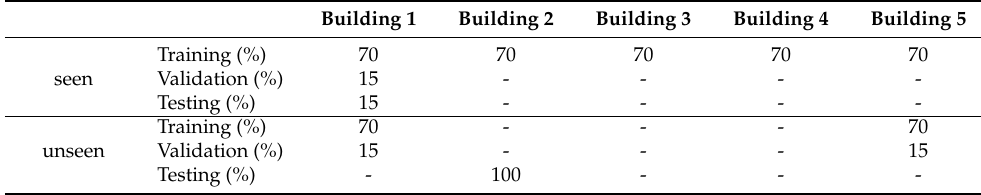
Table 5. Dataset partitioning for the seen and unseen